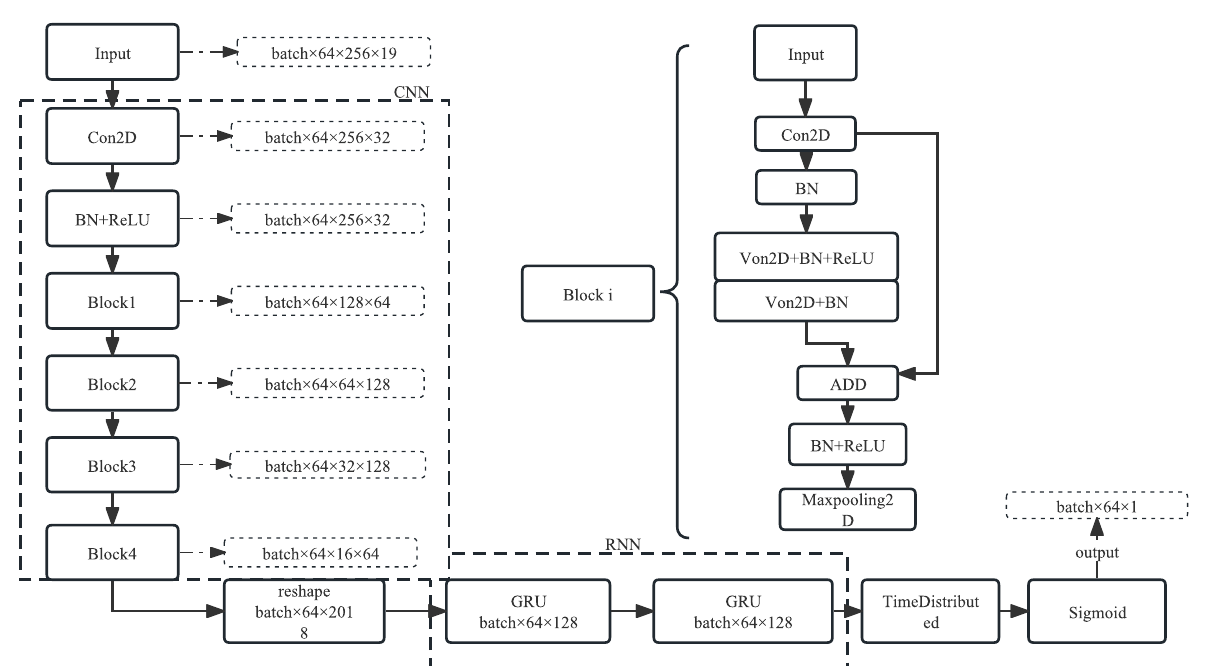
Fig. 1 The network framework of CNN and bidirectional